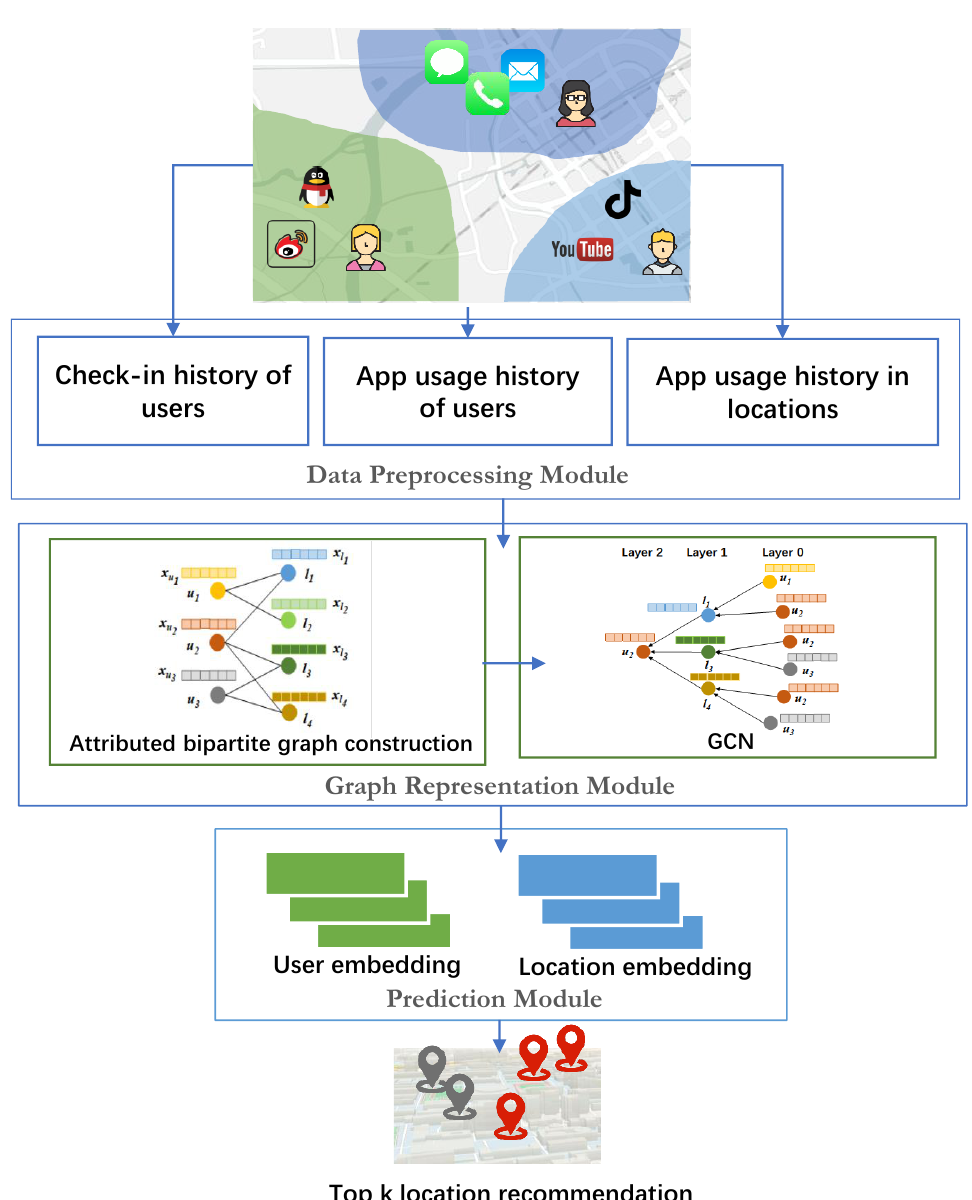
Figure 2. Our Proposed Personalized Location Recommending Framework based on app